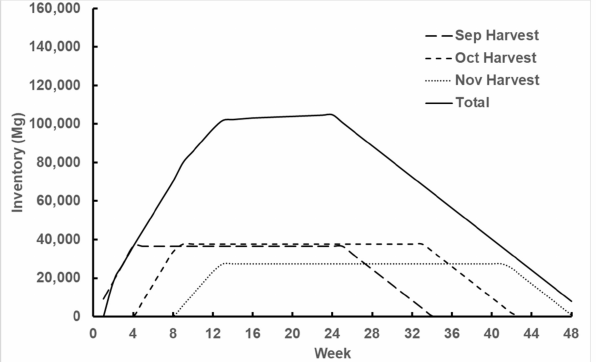
Figure 5. Inventory in satellite storage locations (SSLs) for weeks 1 through 48 for the three-month window. (Results obtained with Scenario 1 MATLAB program).